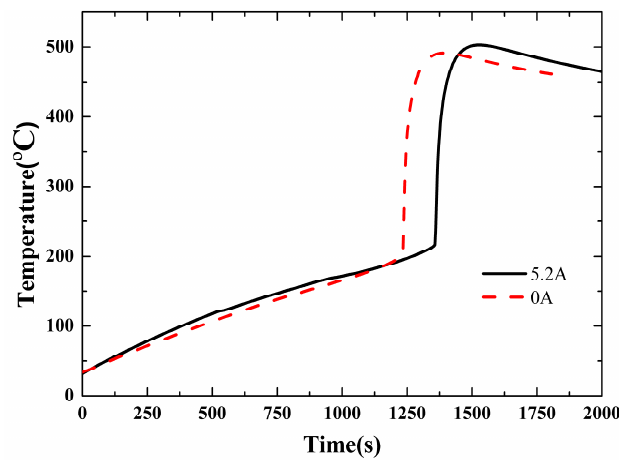
Figure 7. Temperature curve of lithium-ion battery under the condition of discharging. Table 5. Experimental results of lithium-ion battery under the condition of discharging.